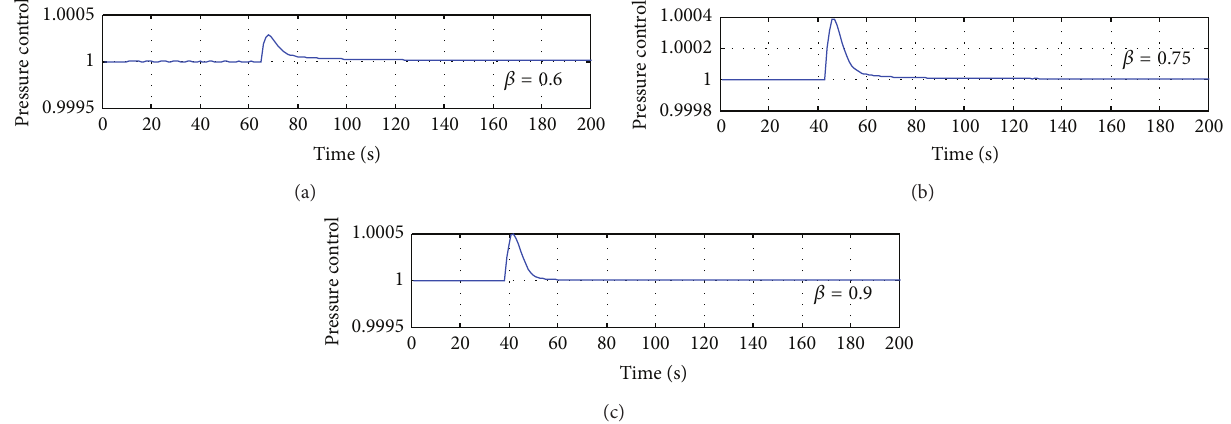
Figure 9: Step response of the fractional order derivative nozzle-flapper-relay for (20).